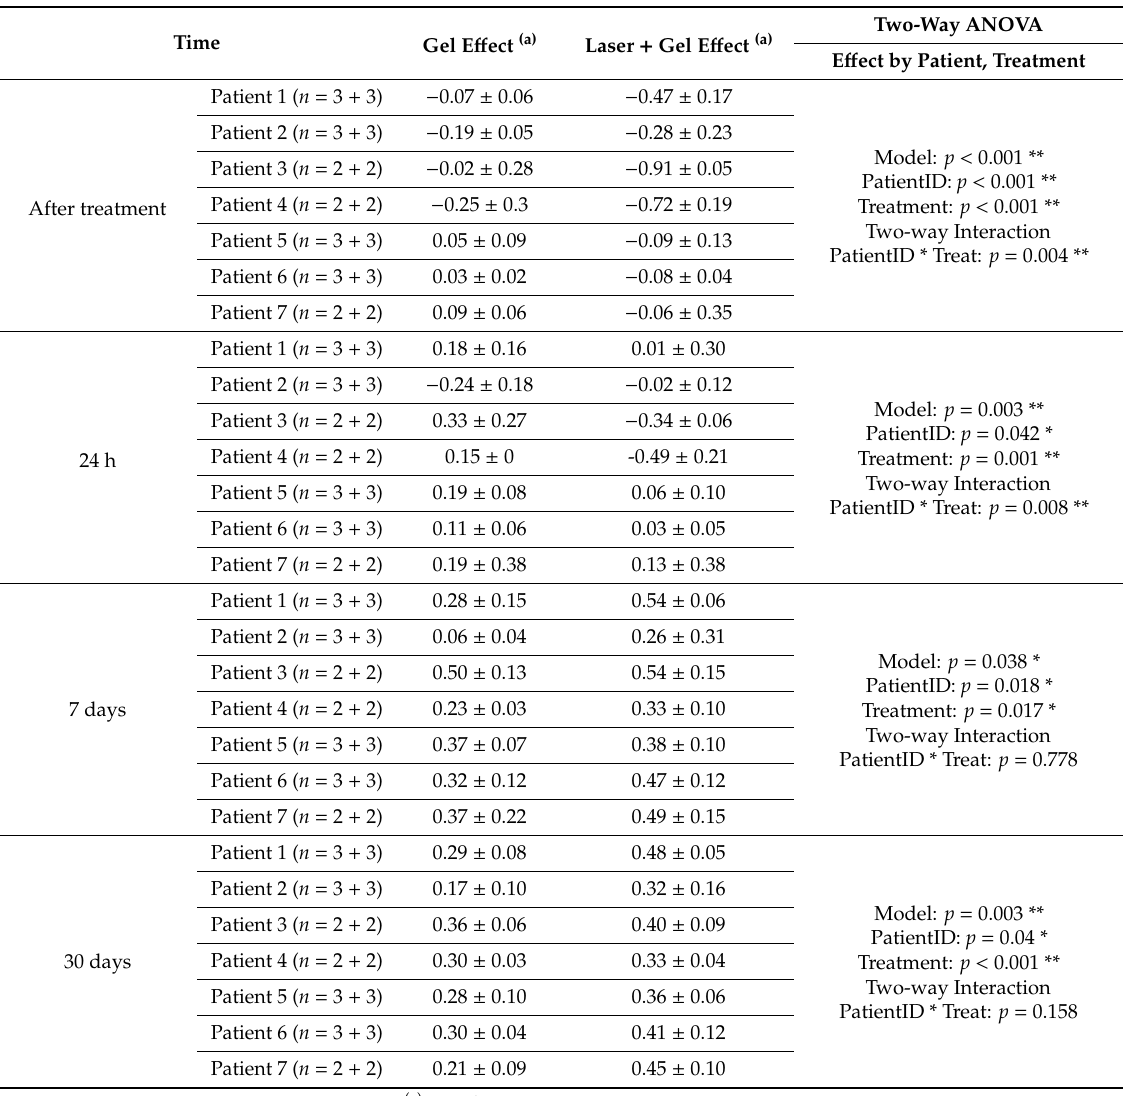
Two-Way ANOVA E ff ect by Patient, Treatment